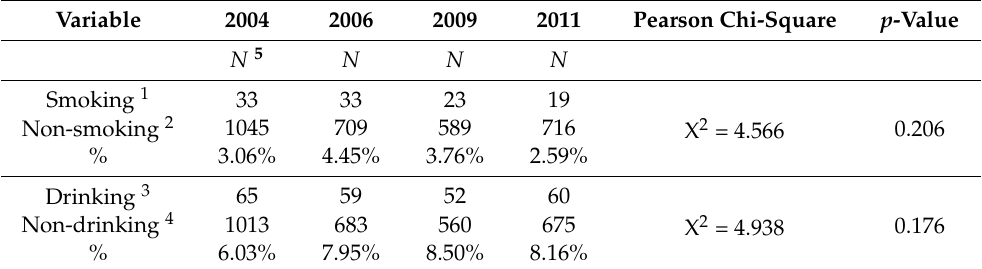
Table 2. Trends in prevalence of alcohol and tobacco consumption among Chinese adolescents (12–18 years old) by survey year, CHNS. Variable